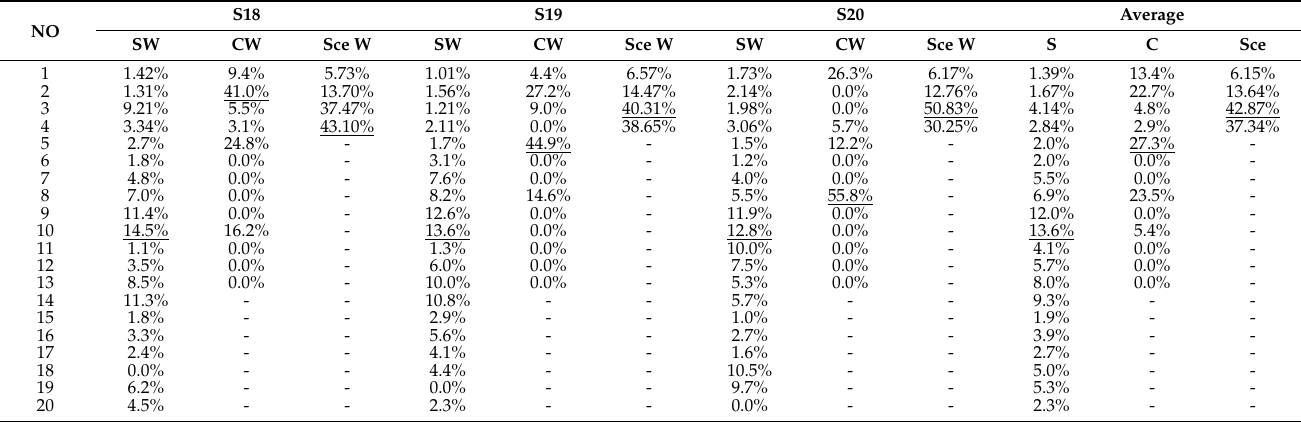
Table A6. Results of pairwise comparison of the Saaty scale (from − 9 to 9) for the user